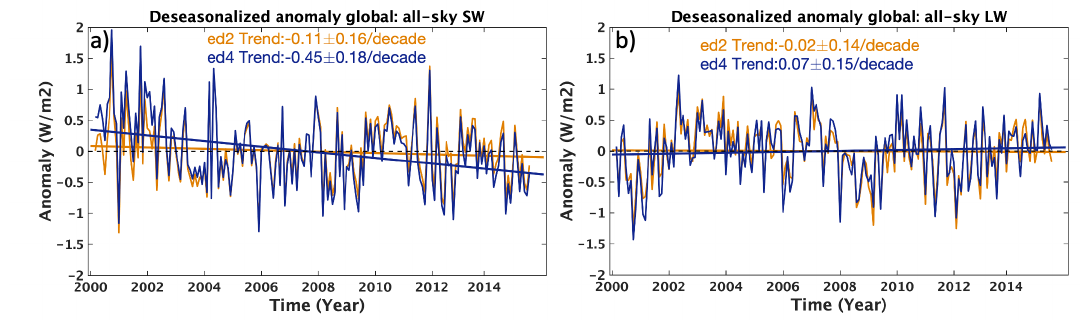
Figure 1. Anomaly in global monthly mean all-sky TOA reflected SW flux ( a ) and TOA LW flux ( b ). Orange lines are for Ed2.8 EBAF and navy lines are for Ed4.0